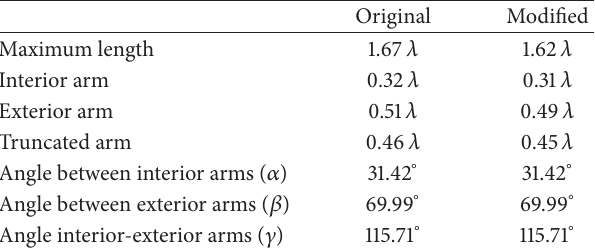
Table 2: Antenna dimensions (RF60A).